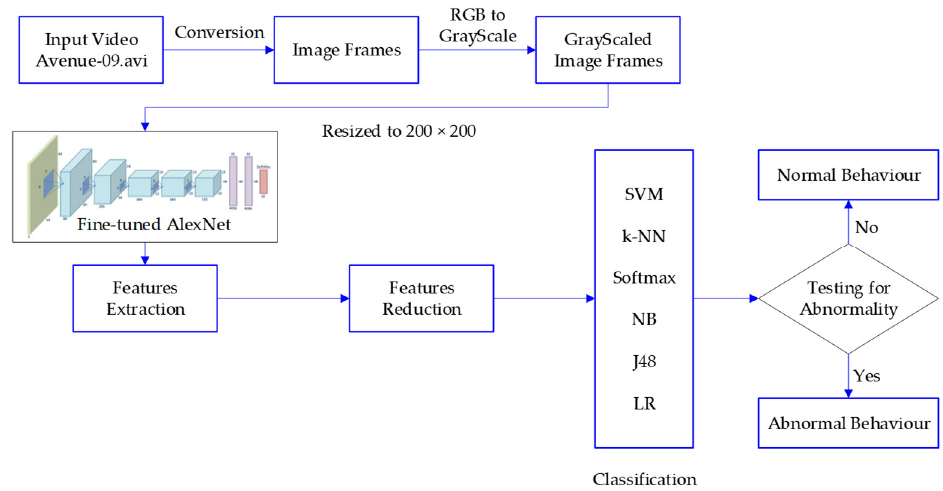
Figure 2. Proposed methodology